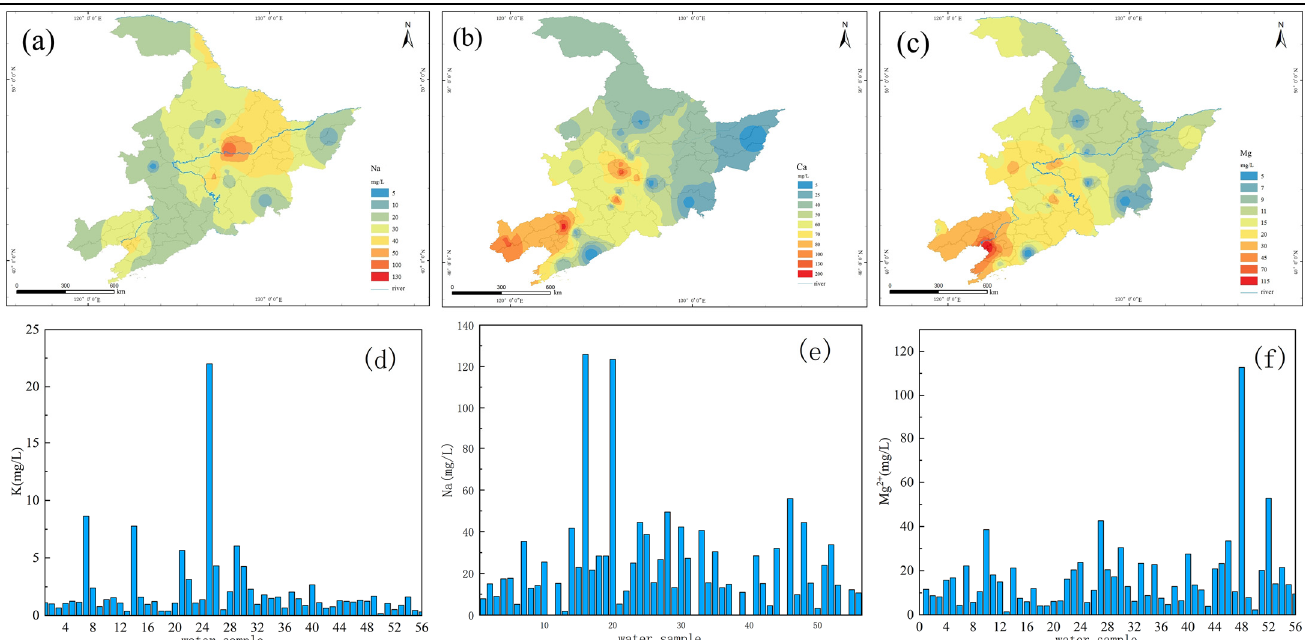
Figure 6. ( a – c ) are the predicted map of Na + , Ca 2+ and Mg 2+ concentration distribution of drinking water sources in M area; ( d – f ) are concentrations of Na + , K + and Mg 2+ in M